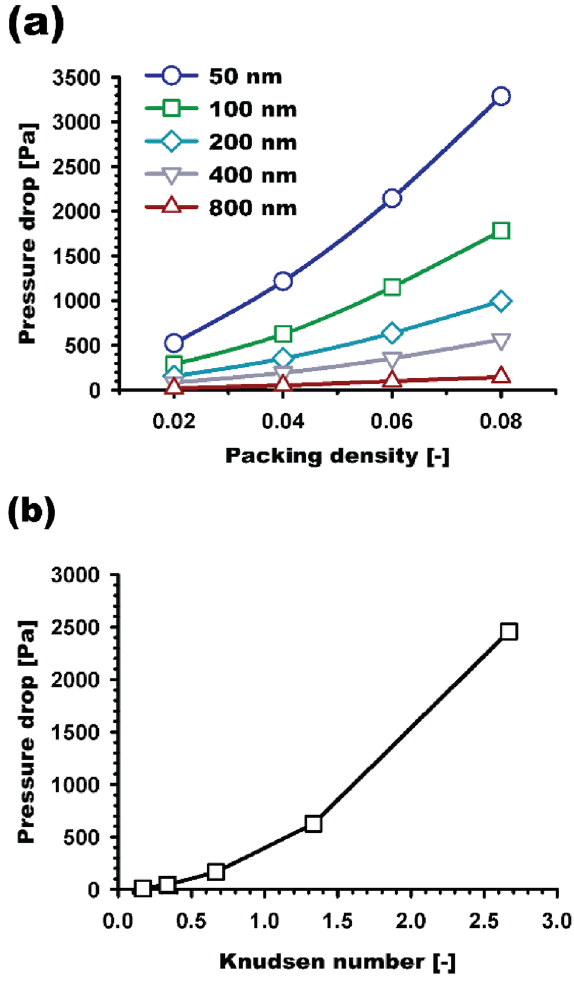
Figure 8. Pressure drop values obtained for the nanofiber filters according to ( a ) packing density and ( b )